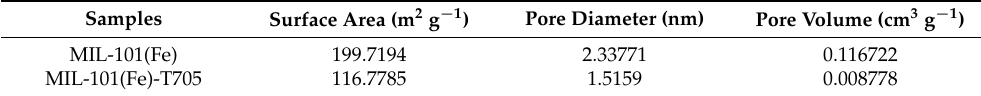
Figure 5. Nitrogen adsorption–desorption isotherms ( A ) and the corresponding pore size distribu- tion ( B ). Table 1. Specific surface area, pore diameter, and pore volume of MIL-101(Fe) and